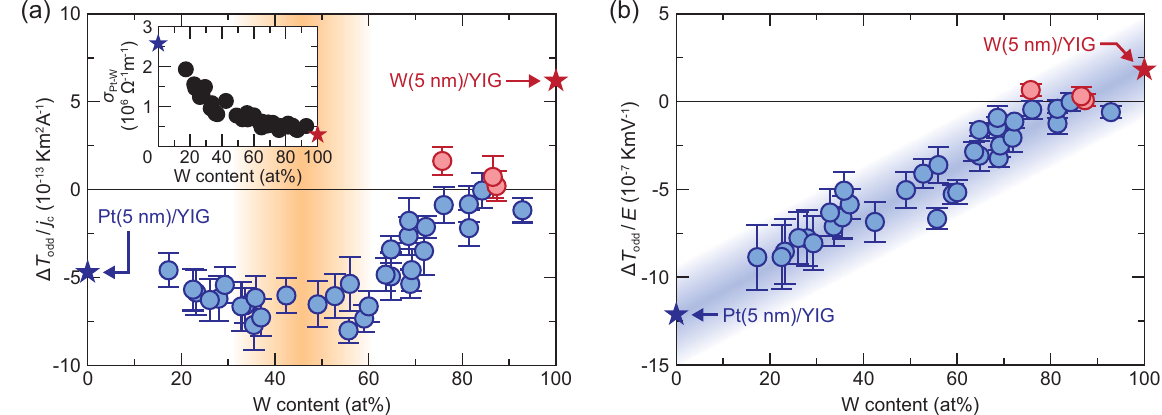
Figure 4. Composition dependence of DSHE-driven SPE in Pt-W/YIG. ( a ) W-content dependence of Δ T odd / j c for the Pt-W/YIG sample. The data points are estimated from the A odd and φ odd values in Fig. 3(d,e) on the areas A1-E7, defined by the squares with the size of 10 × 10 pixels. The error bars represent the standard deviation of the data in the corresponding areas. The inset to ( a ) shows the W-content dependence of the electric conductivity σ Pt-W of the Pt-W alloys. ( b ) W-content dependence of Δ T odd / E for the Pt-W/YIG sample, where E = j c / σ Pt-W is the electric field in the Pt-W film. The blue (red) circle data points show the negative (positive) temperature-modulation signals for the Pt-W/YIG sample. The blue (red) star data points show the SPE signals for the Pt/YIG (W/YIG) system with the 5-nm-thick Pt (W) layer 19 or electric conductivity values for the Pt (W) layer 23,44